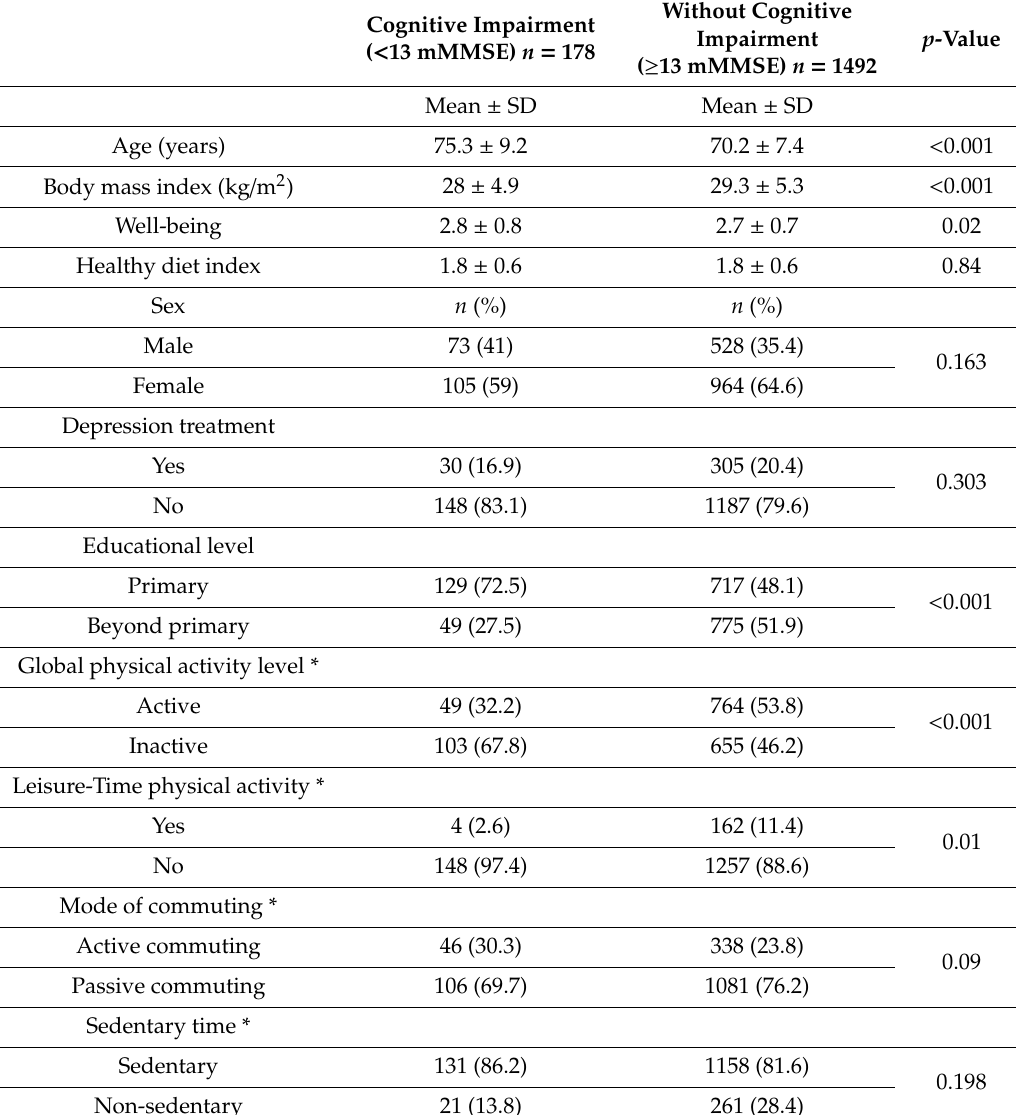
Table 1. Descriptive characteristic of elderly adults according to cognitive